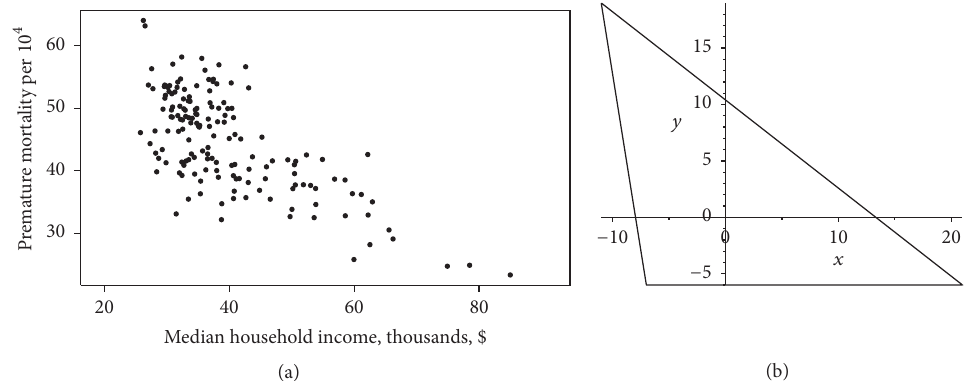
Figure 9: Median household income and premature mortality in the counties of Georgia, averaged from 2008 through 2011 (a) and contour defining triangle P (b).